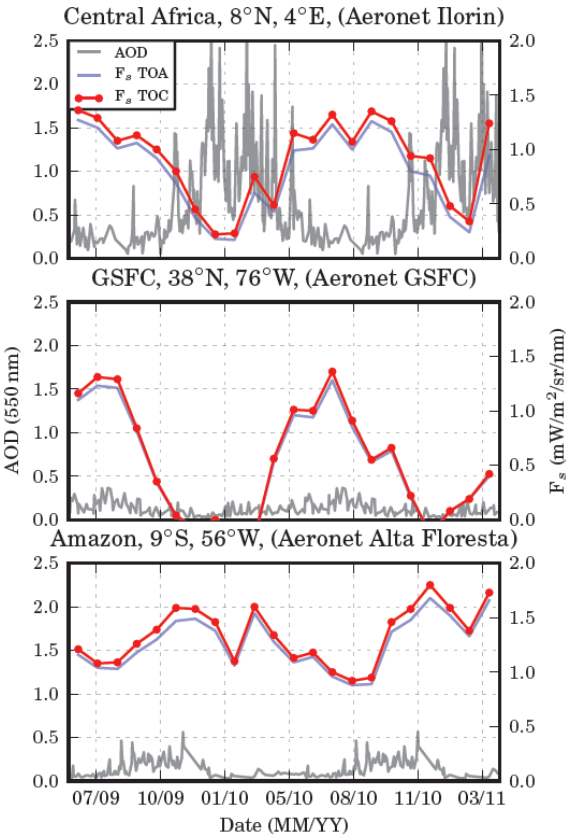
Fig. 13. Temporal series of top-of-atmosphere (TOA) fluorescence and the subsequent top-of-canopy (TOC) fluorescence after com- pensation of atmospheric extinction (scattering+absorption) for lo- cations in Central Africa (top), Greenbelt, MD (middle) and the Amazon